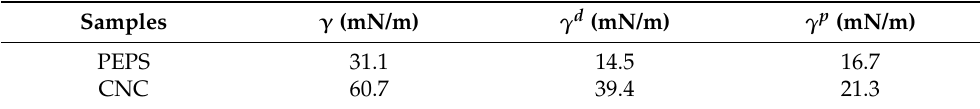
Table 2. Surface energy data of PEPS and